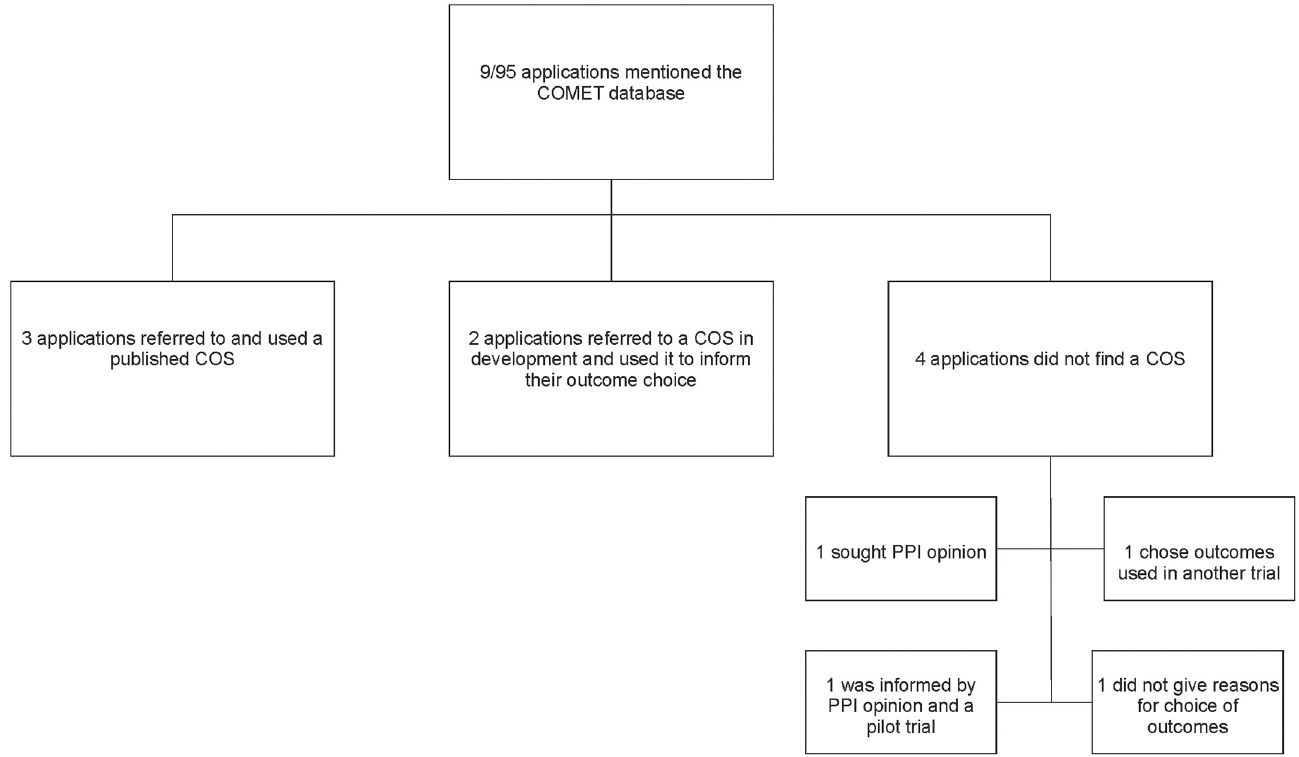
Fig 1. Applications that referred to a search of the COMET database for a COS.